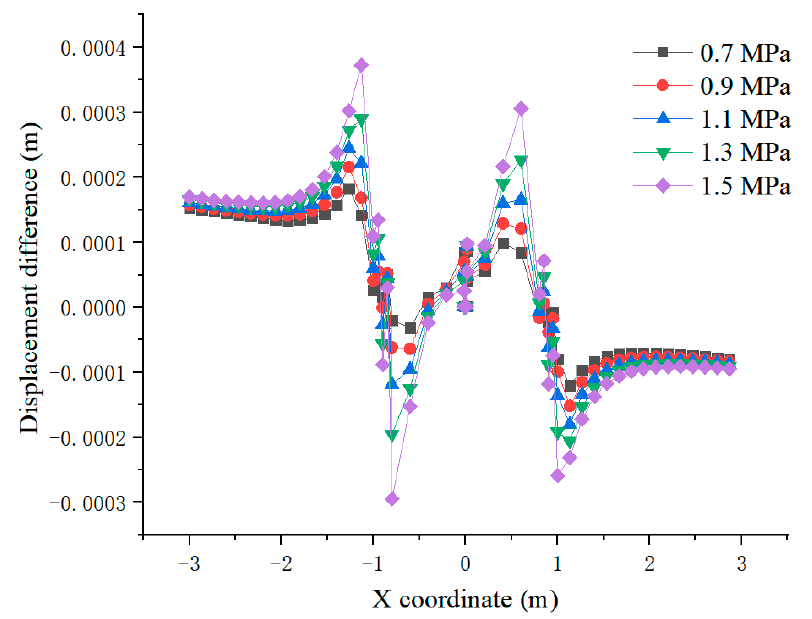
Figure 15. Distribution of displacement difference at 14.625 m under different load amplitudes.